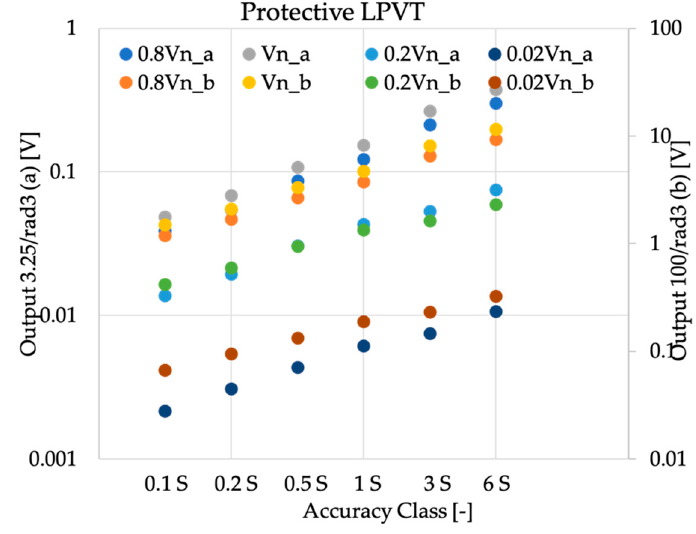
Figure 5. Absolute values of o computed from the rated outputs of Table 1 for protective purpose voltage transformers.